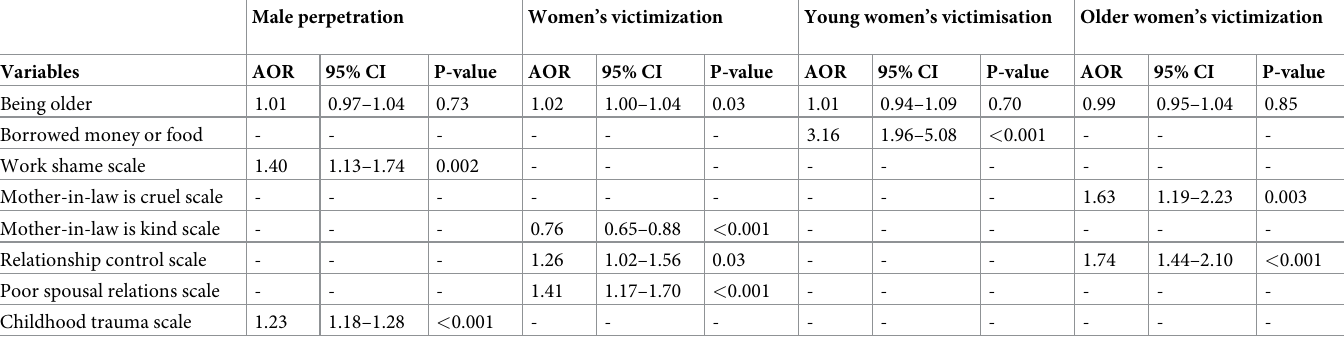
Table 2. Multivariate associations of IPV perpetration by men and victimisation of women in lifetime and comparisons among women by in-law status. Male